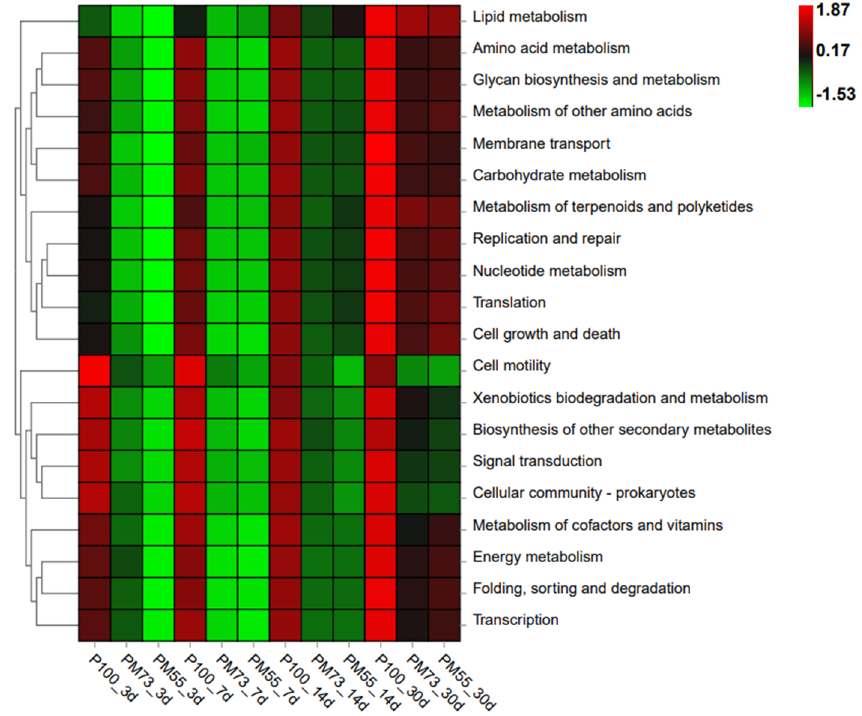
Figure 4. Heatmap of 16S rDNA gene-predicted functional profiles obtained with PICRUSt2 (P100, 100% hybrid Pennisetum silage; PM73, hybrid Pennisetum and mulberry leaves mix-silage in a ratio of 7:3; PM55, hybrid Pennisetum and mulberry leaves mix-silage in a ratio of 1:1; 3d, 3 days of ensil- ing; 7d, 7 days of ensiling; 14d, 14 days of ensiling; 30d, 30 days of